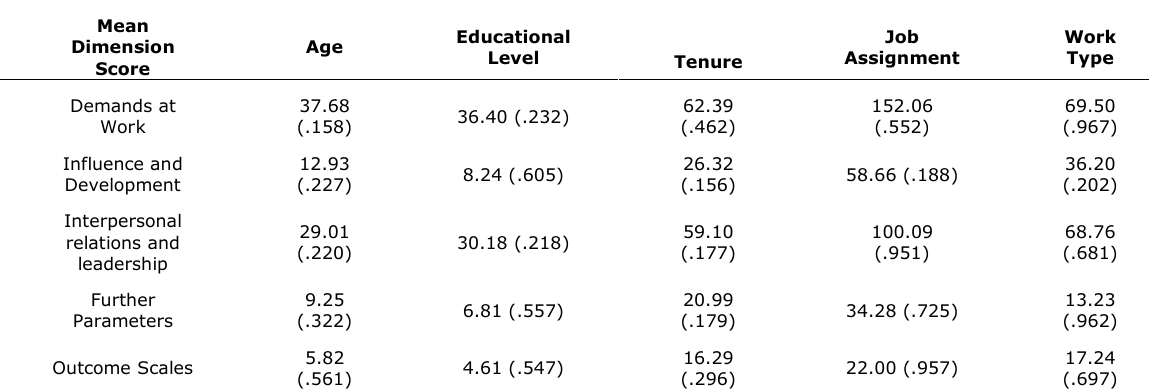
Table 7. Coefficients (p-values) of Chi-square tests between psychosocial health and socio-demographic profile of off-shore personnel